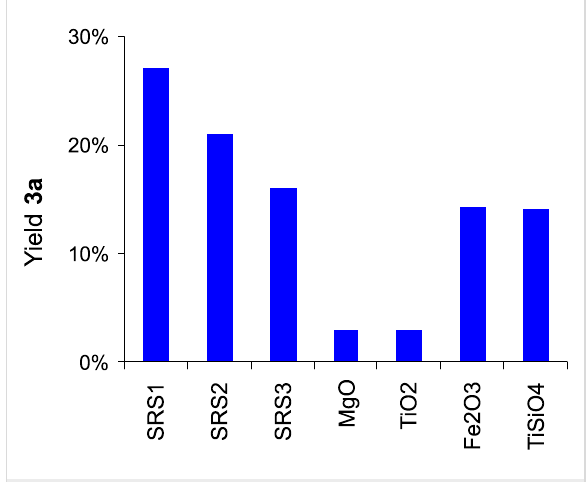
Figure 1: Results of the Suzuki–Miyaura reaction of phenylboronic acid ( 1 ) with p -bromoacetophenone ( 2a ; cf. Scheme 1) assisted by various metal oxides [5 g; SRS1 – 3 : cf. Table 2; ball milling: 2 agate milling beakers ( V = 45 ml), 6 agate milling balls ( d = 15 mm) per beaker, 800 rpm, 10 min; batch: 5 mmol 2a , 124 mol % 1 , 3.6 mol % Pd(OAc)